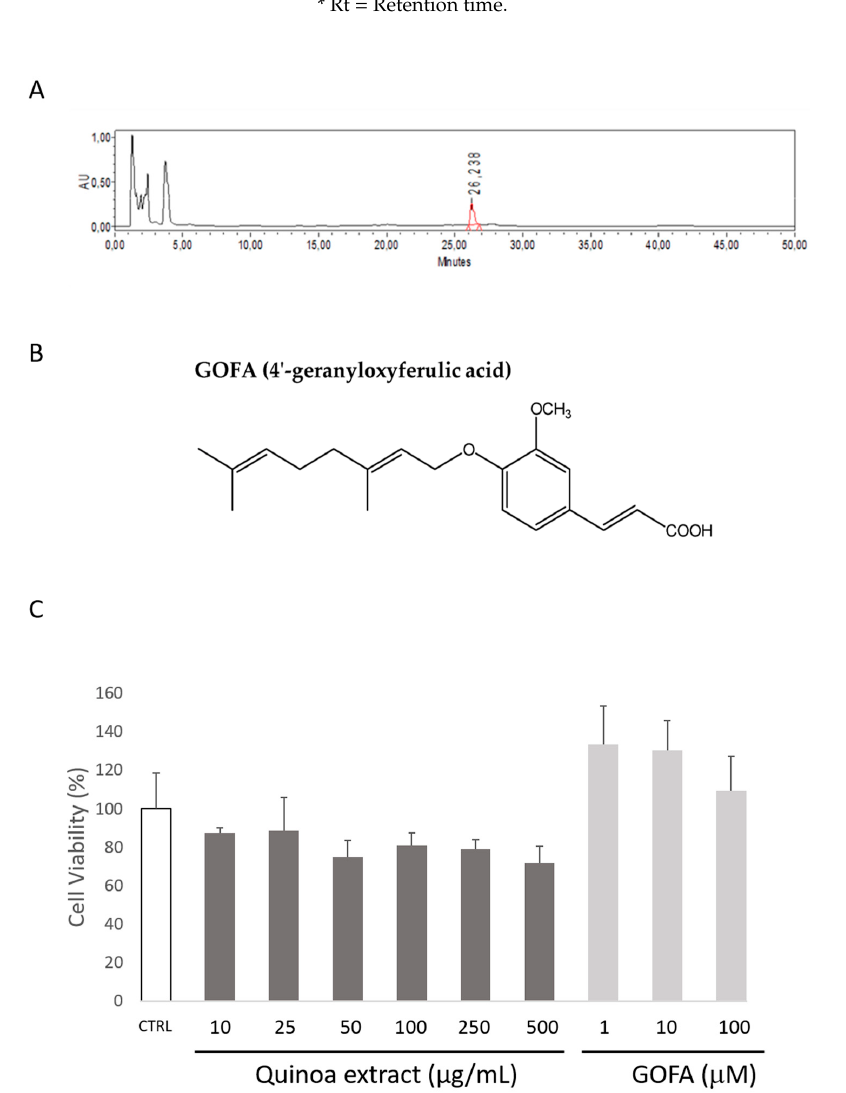
Figure 1. ( A ) HPLC chromatogram of quinoa roasted seeds ethanolic extract. Peak with Rt of 26.2